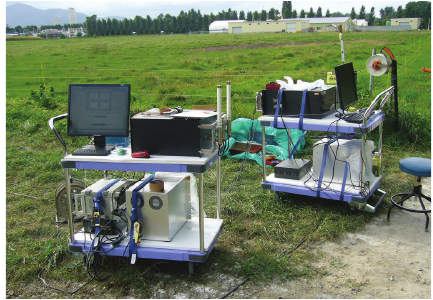
Figure 1: Photograph of experimental platform.